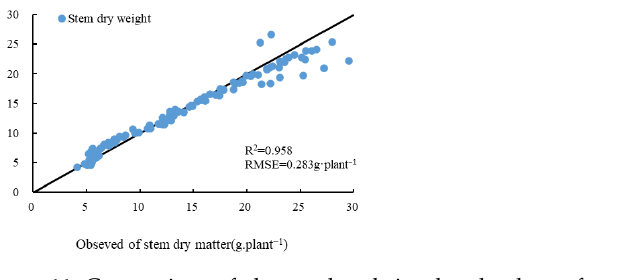
Figure 11. Comparison of observed and simulated values of stem dry weight fit under LT and PL